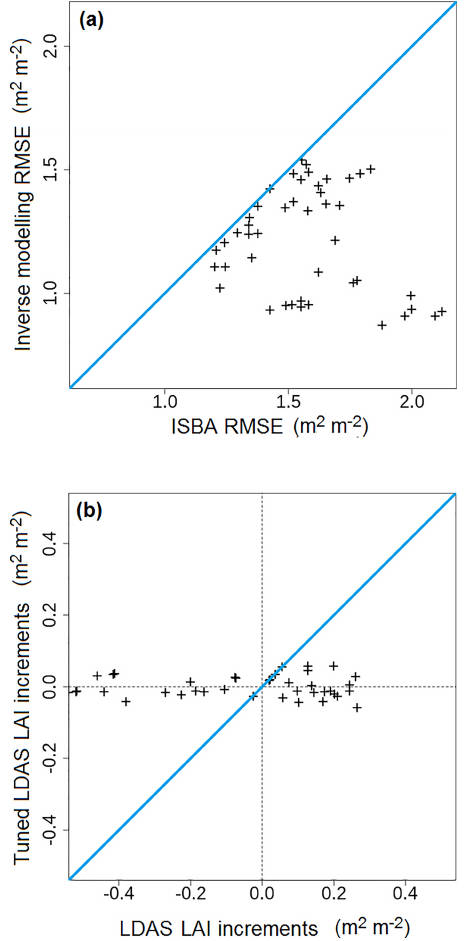
Figure 5. Cost function values during the senescence period af- ter vs. before LAI observation integration for all 45 départements: (a) LAI RMSE (Eq. 11) for inverse modelling and (b) LAI analysis increments (Eq. 2) for LDAS tuning. Identity lines are in